Question: Provide a one-line summary of what is displayed.
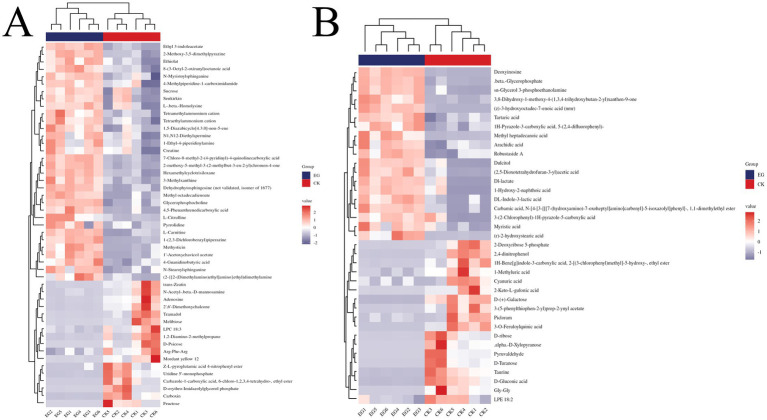
Answer: Hierarchical clustering heatmap of differentially expressed metabolites under positive and negative ion modes. (A) Positive ion modes; (B) Negative ion modes.